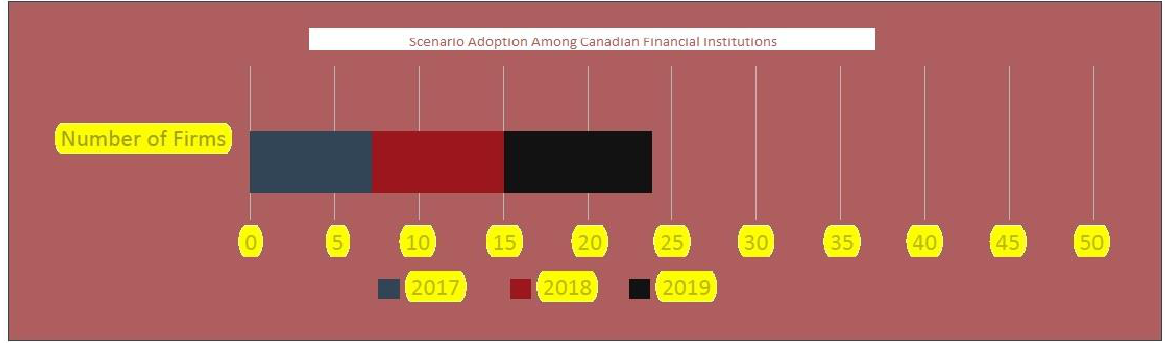
Figure 4: Climate-related Disclosure of Financial Sector in the Canadian Specific Financial Industry: Three-Year Based Progress